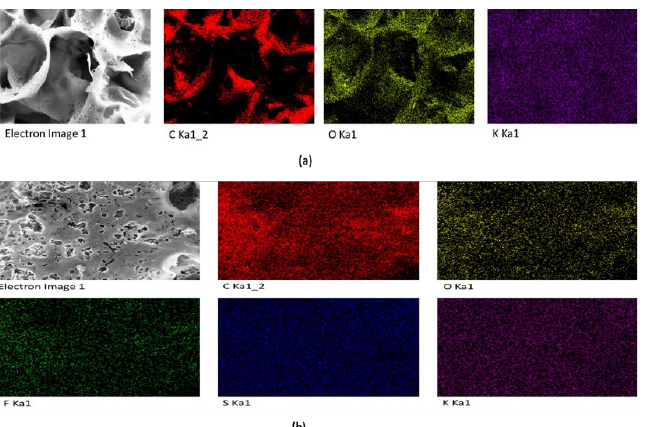
Figure 4. ( a ) EDX elemental mapping of fresh AC for C, O and K. ( b ) EDX elemental mapping of IL functionalized AC for C, O, F, S and K.